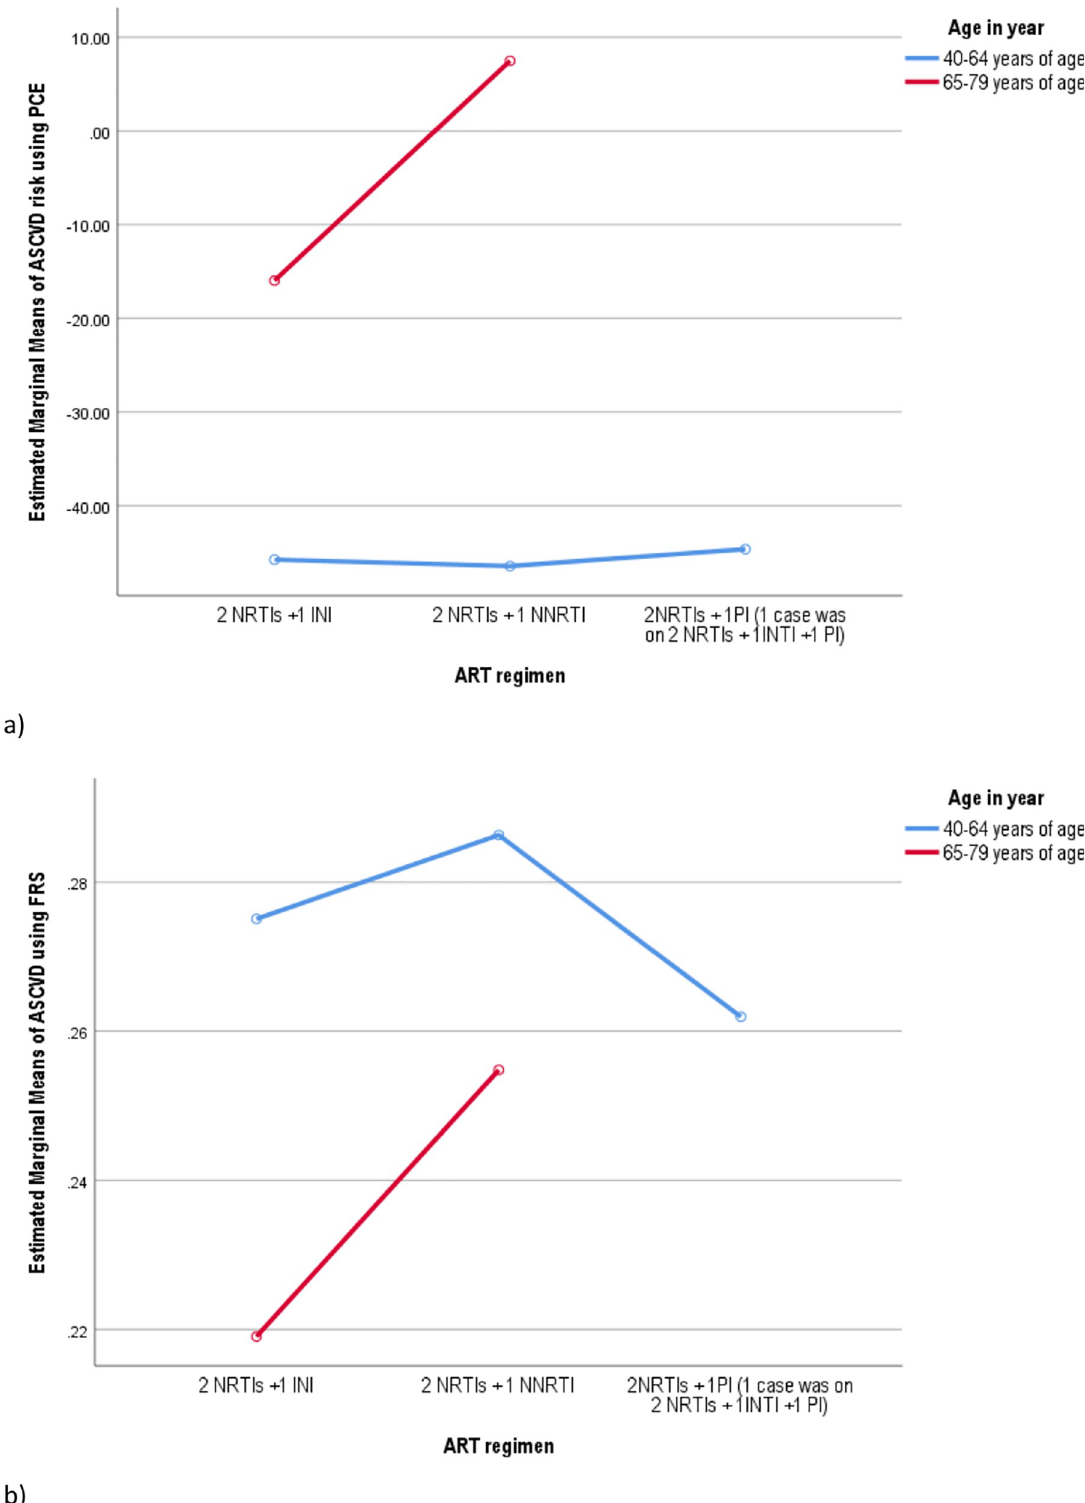
Fig 2. The ASCVD risk based on ART regimen and age interaction among PLWHA age 40–79 years: using the pooled cohort equation (a), and the Framingham risk score (b) estimation.